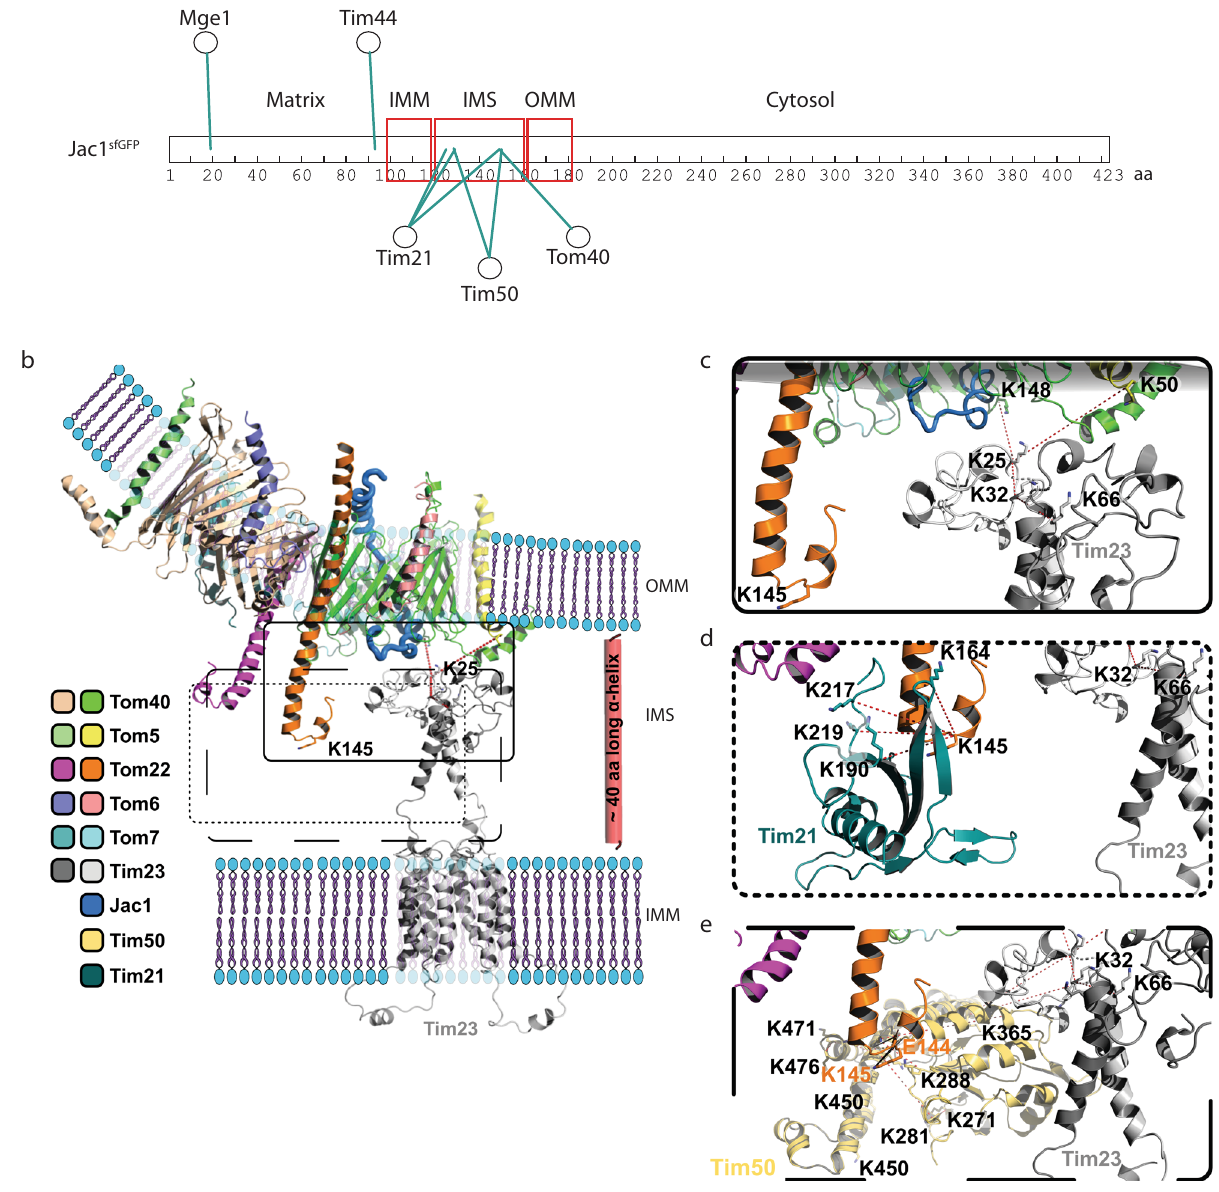
Fig. 4 N-terminus of Tim23 is localized in proximity to the TOM complex. a Mapping of cross-links obtained between Jac1 sfGFP and various supercomplex subunits, indicating its relative position within the supercomplex. b Structural model representation of Tim23 relative to the TOM complex, indicating cross-links (red dashed line) between Tim23 (K25, gray), Tom40 (K148, green), and Tom5 (K50, yellow) in the intermembrane space (IMS). Red helix represents the region of Jac1 sfGFP predicted to be localized in the IMS based on ( a ). The model utilizes structural information from available TOM complex: 6JNF and Tim23: 7CLV structures. The color code indicates individual subunits. c Close-up view of the Tim23-Tom40 and Tim23-Tom5 cross-links. d Illustration showing Tim21-Tom22 cross-links using the structure of the IMS domains of Tim21 (cyan, PDB id: 2CIU). e Interaction between Tim50-Tim23 and Tim50-Tom22 based on cross-links. Tim50 (mustard) is indicated as a combination of the known structure of Tim50 CORE (PDB id: 3QLE) and an ab initio predicted model for the C-terminal domain. OMM: outer mitochondrial membrane, IMS: intermembrane space, IMM: inner mitochondrial